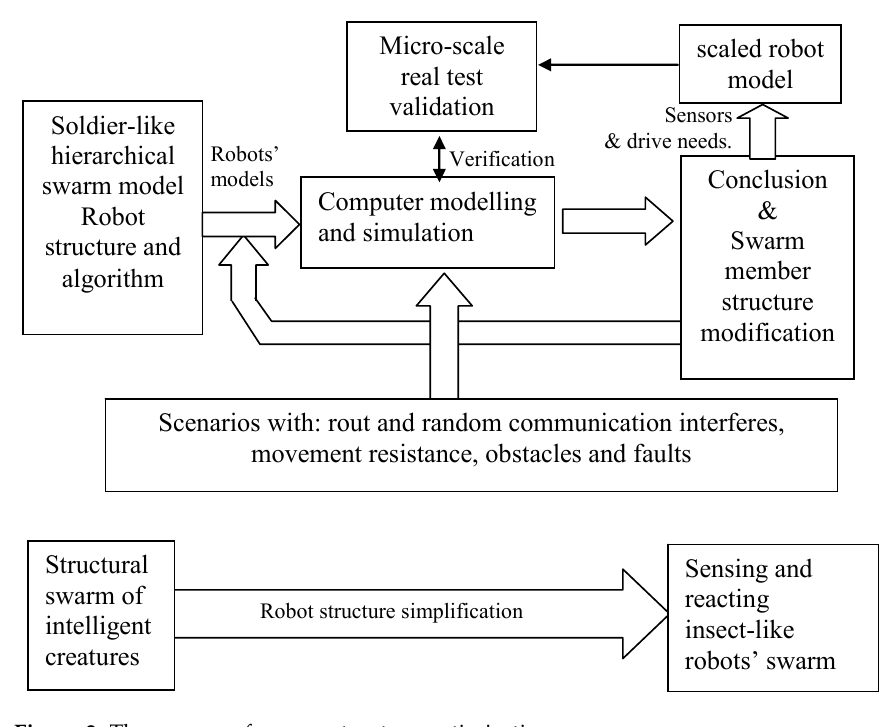
Figure 3. The process of swarm structure optimisation.